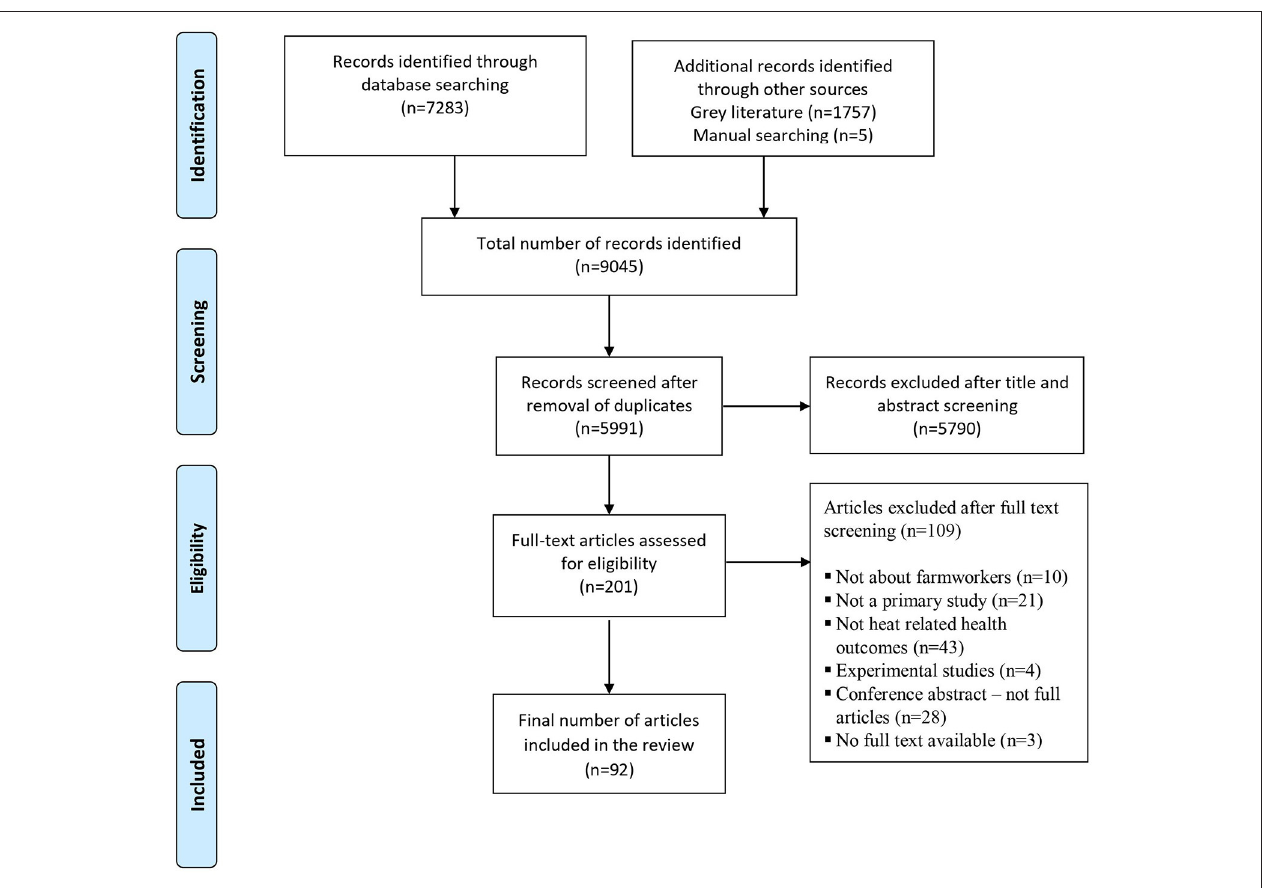
FIGURE 1 | Flow chart of selection process for included